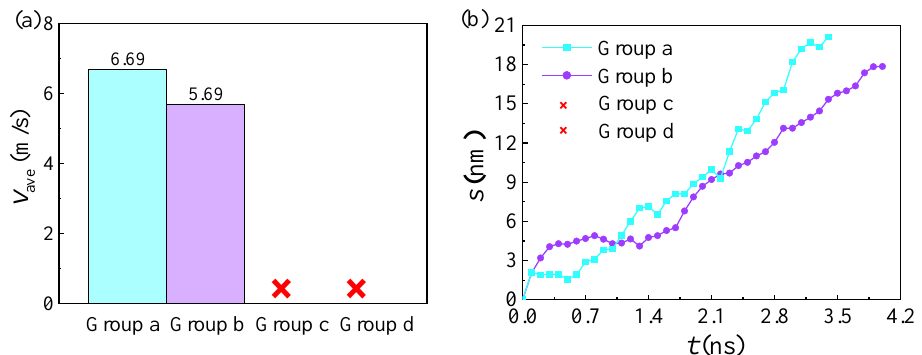
Figure 6. Influences of the wettability difference. ( a ) Average motion velocities of the droplet at varying wettability differences. ( b ) Motion courses of the droplet over time at varying wettability differences.